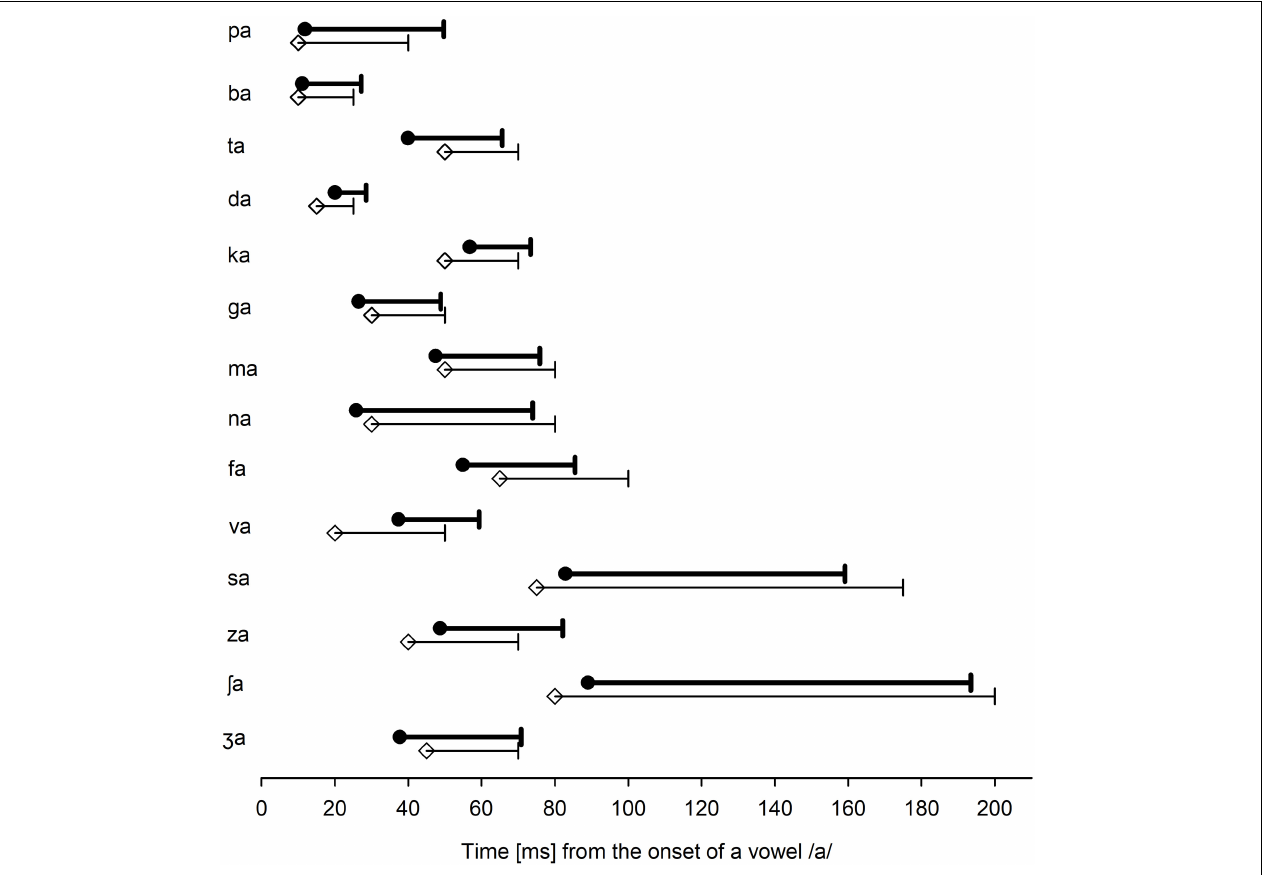
FIGURE 3 | The mean target time ranges (filled circles) for each consonant. Note that the target time ranges indicate a temporal segment from an onset of the vowel /a/. For comparison, the target time ranges, as reported by Li et al. (2010, 2012), are also presented (open diamond